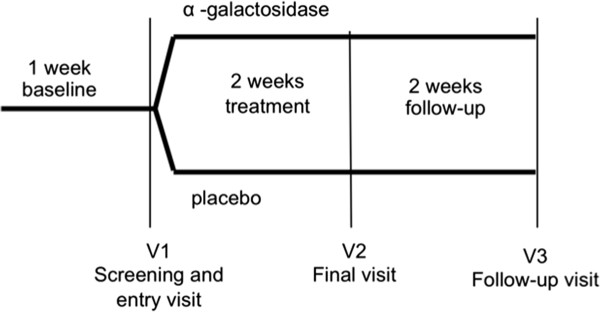
Study flow chart.